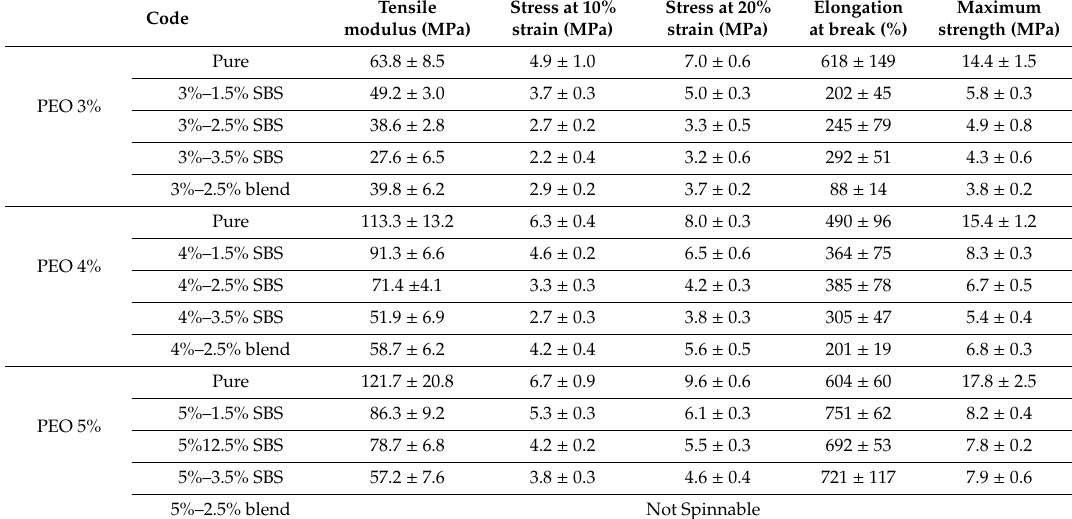
Table 3. General tensile properties of electrospun fiber mats of pure PEO, blend PEO / PANI, and side-by-side (SBS) PEO /